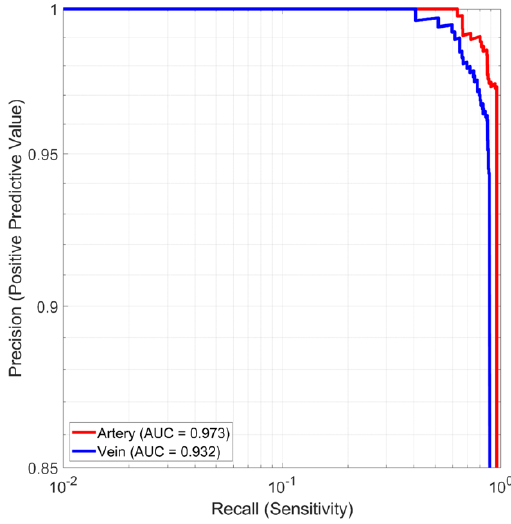
Figure 7. Vessel detection and classification accuracy.